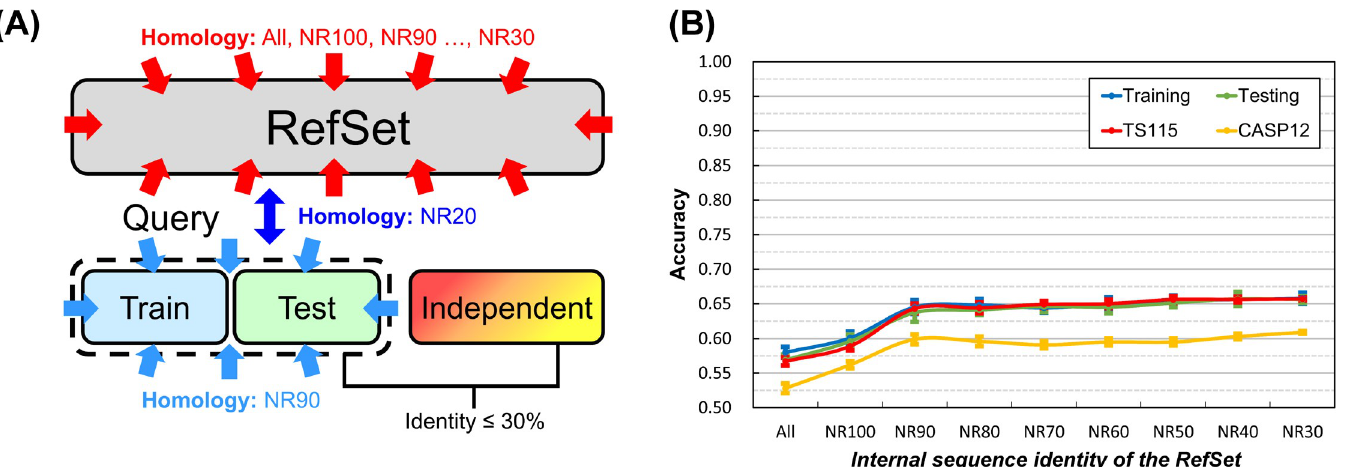
Fig 5. Effects of the homology reduction of the PSSM reference dataset on the accuracy of secondary structure prediction. (A) The layout of datasets. The homology of the PSSM reference dataset was reduced with a series of sequence identity cutoffs; the lowest was 30% because when 25% or 20% were applied, the remaining sequences would be insufficient to sustain the required dataset sizes (Fig 1A). The homology between training/testing query sets and the reference dataset was manipulated to be < 20% sequence identities. The inter- and inner-dataset identity cutoff of training and testing query datasets were both 90%, set high for preserving sufficient sequences. (B) The SSP accuracy obtained at different homology levels of the reference dataset. The overfitting of prediction in training and testing was much suppressed because of the fixed low query-reference dataset homology. More importantly, the accuracy increased as the homology of reference sequences lowered. The same conclusion applied to SOV (see S5 Fig). This phenomenon had not been clearly reported before our study. See Fig 6 for advanced tests.